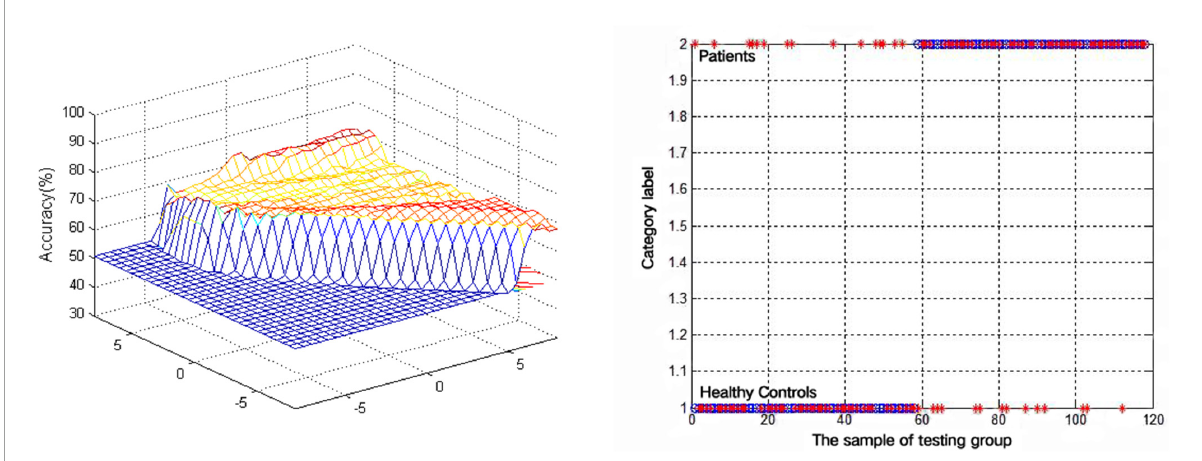
FIGURE2 Visualization of classifications through support vector machine (SVM) using the decreased VMHC values in the MTG to discriminate lTLE patients from HCs. Left: SVM parameters result of 3D view. Right: Classified map of the VMHC values in the